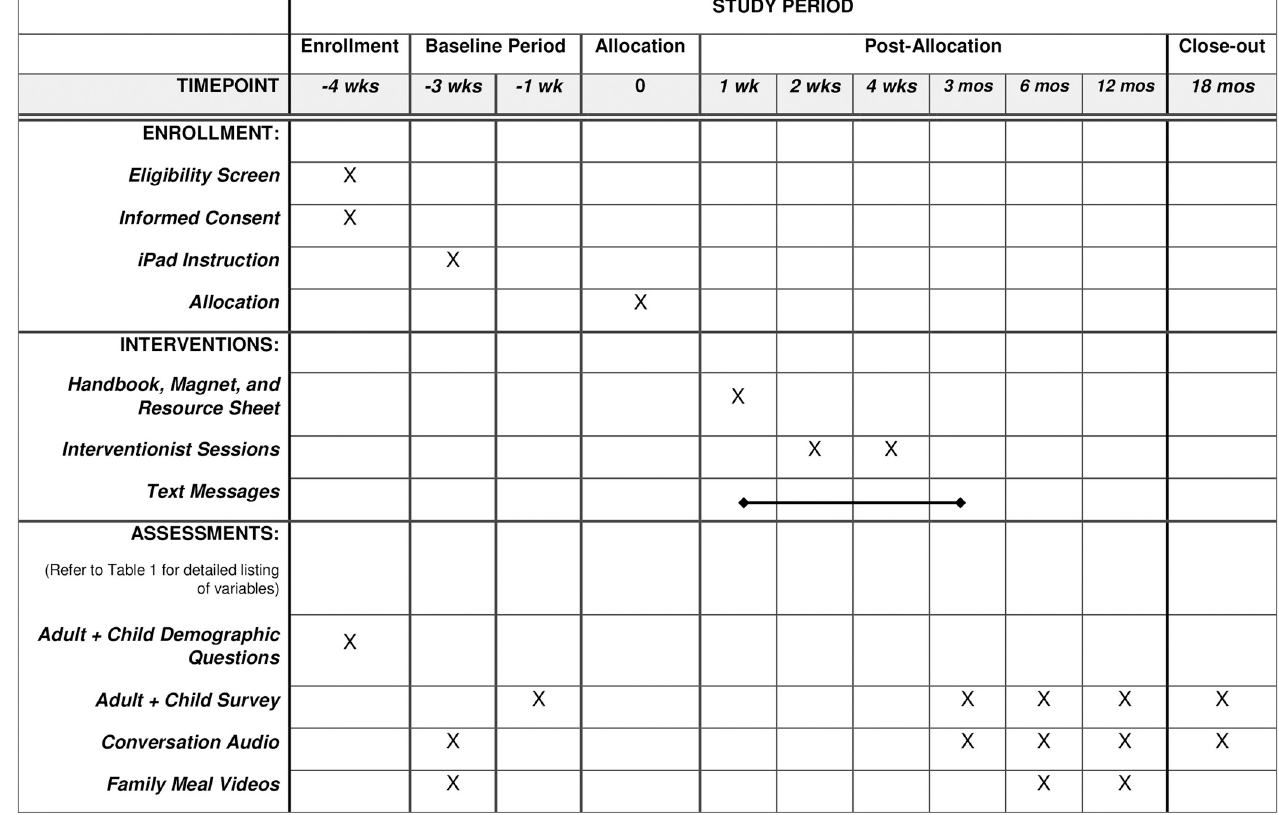
Fig 1. Schedule of enrollment, intervention and